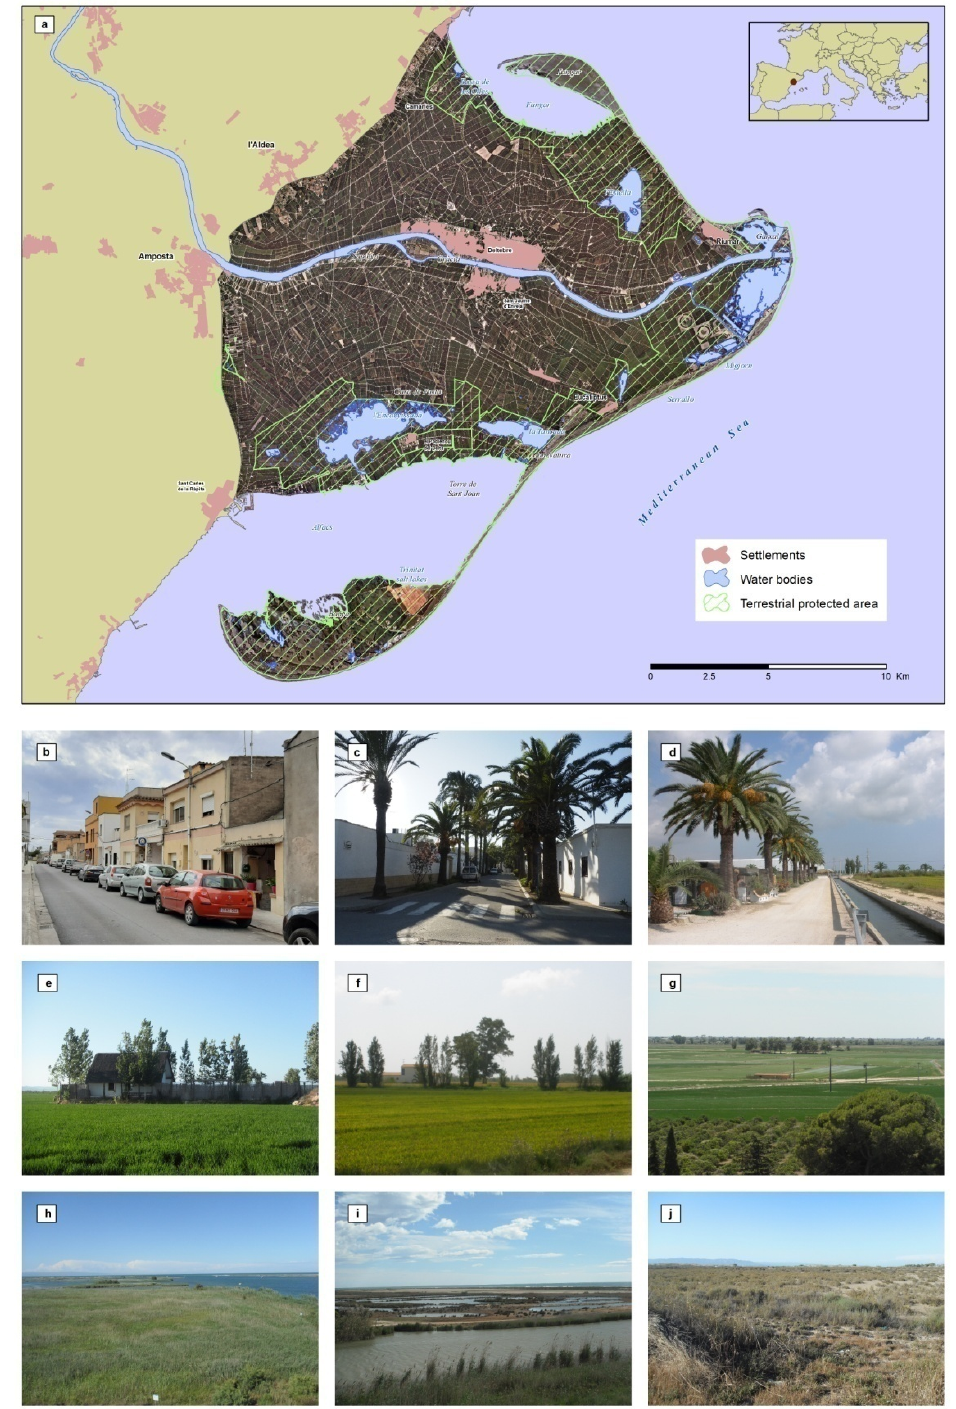
Figure 1. Settings of the Ebro Delta: ( a ) location map; ( b – d ) urban landscapes; ( e - g ) agrarian land- scapes; ( h – j ) natural